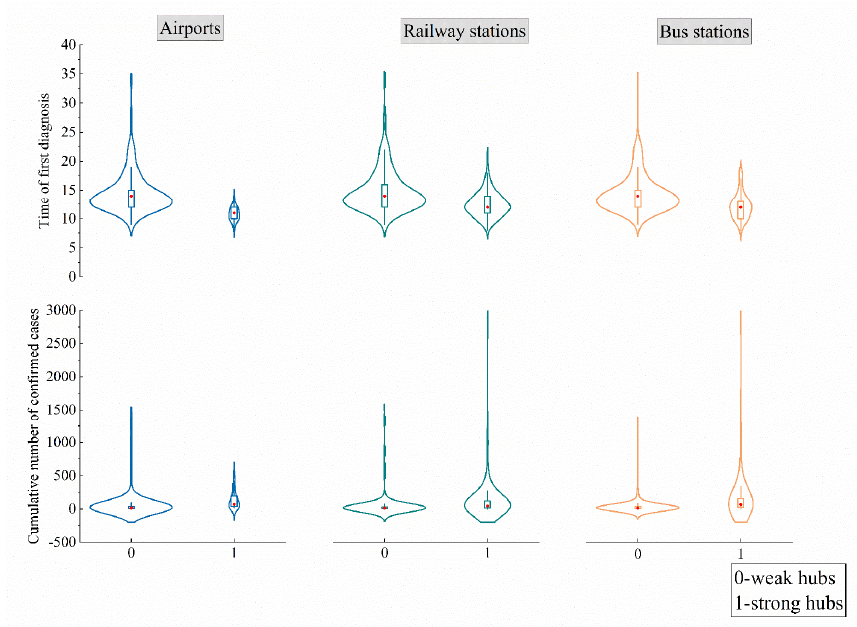
Figure 4. Distribution of the epidemic transmission in two levels of transportation facilities.